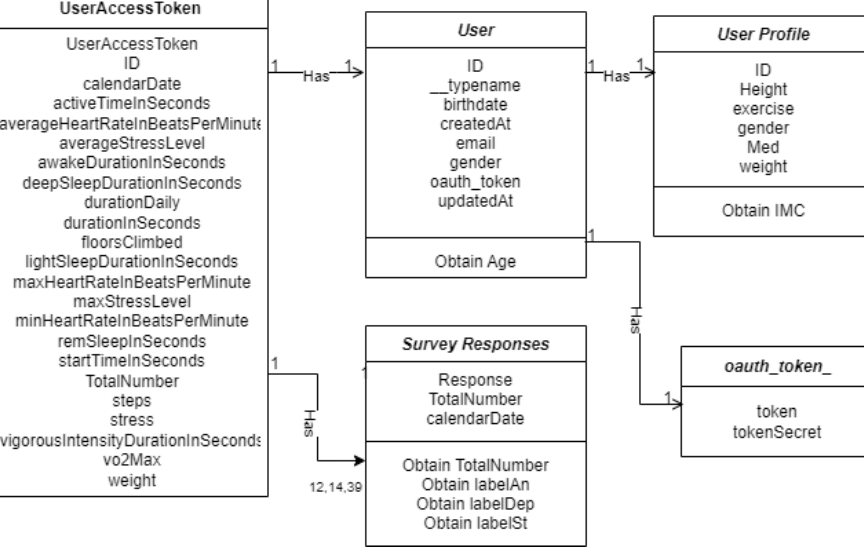
Figure 3. Front-End and Back-End of LM